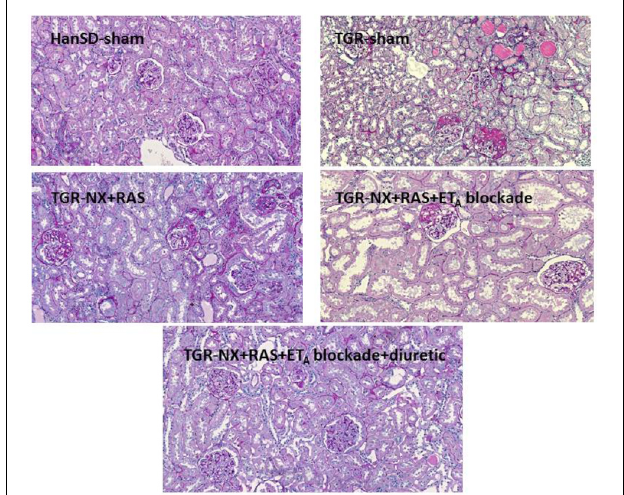
FIGURE 6 | Representative images of renal histology. Renal parenchyma without morphological alterations in control sham-operated HanSD rats (HanSD-sham). Extensive secondary focal segmental glomerulosclerosis and small zone of atrophic tubules (the upper right part) in sham-operated heterozygous Ren 2 transgenic rats (TGR-sham). RAS blockade only partially improved morphology of renal parenchyma; focal segmental glomerulosclerosis persists as well as glomerular enlargement in nephrectomized TGR (TGR-NX + RAS). Combined RAS and ETA blockade substantially atenuated renal injury in nephrectomized TGR; glomeruli contain segmental tuft sclerosis only sporadically (TGR-NX + RAS + ET A blockade). Treatment with diuretic added to the combined RAS+ETA blockade most significantly protected renal parenchyma from injury in nephrectomized TGR (TGR-NX + RAS + ET A blockade + diuretic). Periodic acid-Schiff staining. Magnification 200 ×